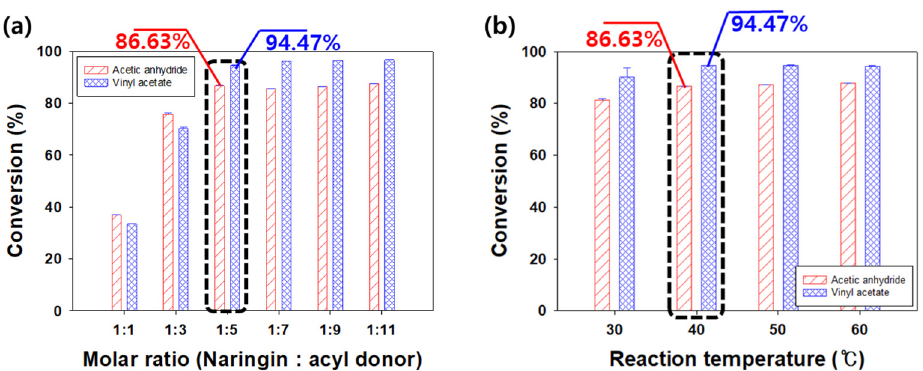
Figure 5. Effects of molar ratio between naringin and acyl donor ( a ), and reaction temperature on the conversion of naringin acetate ( b ).